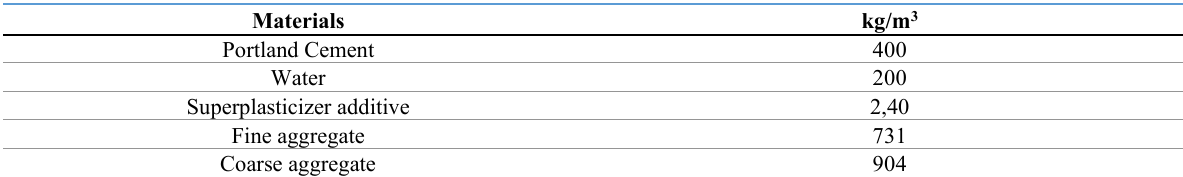
Table 1. Mixture of Self Compacting